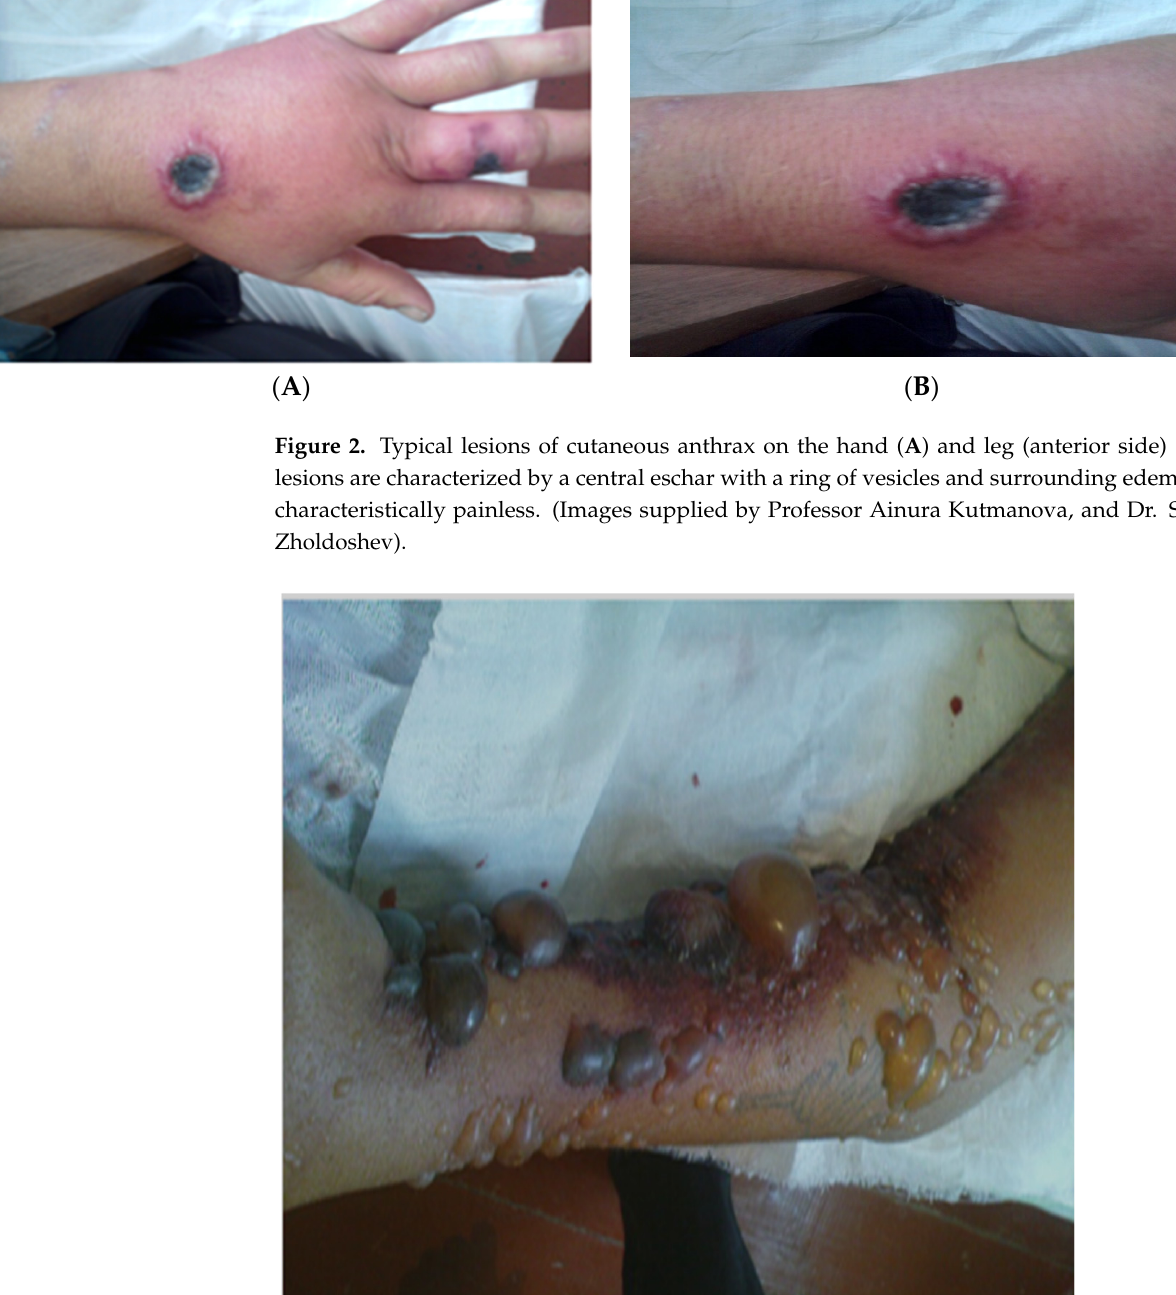
Figure 3. Typical appearance of a severe form of cutaneous anthrax lesions on the arm. Extensive erythema and oedema as well as hemorrhagic bullae can be seen (Image supplied by Professor Ainura Kutmanova and Dr. Saparbai Zholdoshev).